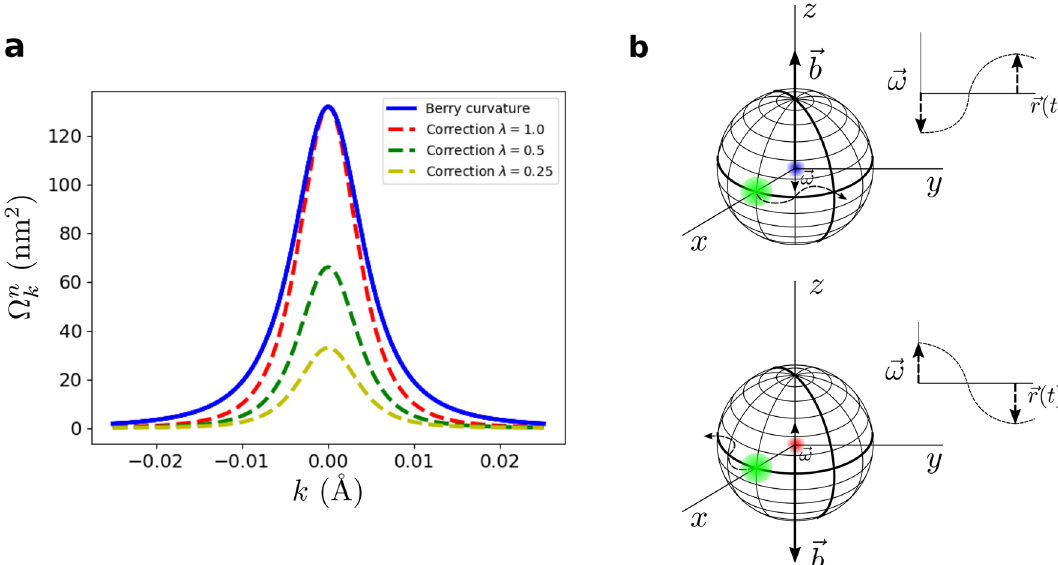
Figure 3. Berry curvature correction and b field interpretation. ( a ) Unperturbed Berry curvature (blue solid line) of the conduction band ( H + ) of a topological insulator ( M < 0 ) and first-order correction to it (dashed lines) for different energy dependent frequencies below the critical frequency ω c = eb / 2 m . The parameters used are M = − 0.025 eV, B = 0 and v F = 6.17 × 10 5 m/s. ( b ) Schematic translation of Berry curvature modulation from the electronic point of view (blue and red points) where in-plane nucleus (green circles) displacements are showed to change the field b defined on each orbital motion. Red and blue points represent electrons with opposite spins for which nucleus move in opposite directions attending to the helical nature of electronic motion in a